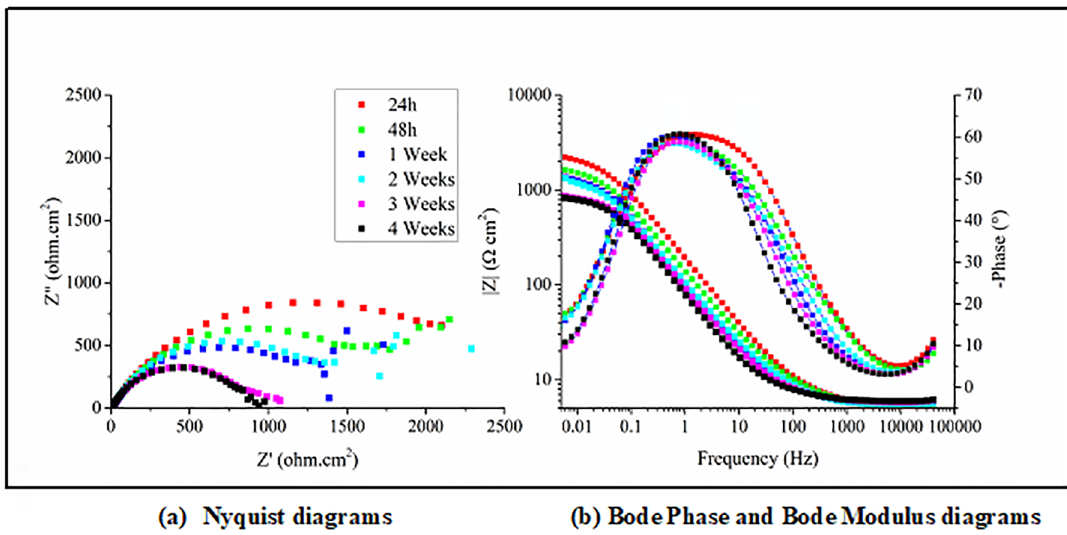
Figure 3. Study S1: (a) Nyquist diagrams; (b) Bode Phase and Bode Modulus diagrams of ASTM A 131 grade A36 carbon steel immersed in diesel oil S10 / saline water in NaCl 3.5 wt.% as a function of the exposure